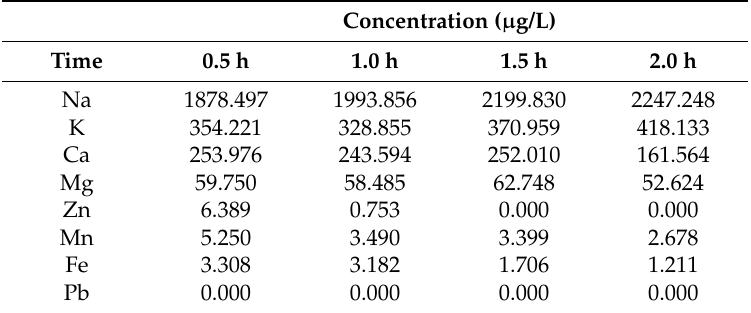
Table 6. Concentrations ( µ g/L) of different elements in System B containing zinc ferrite, ETS-10 and water at different